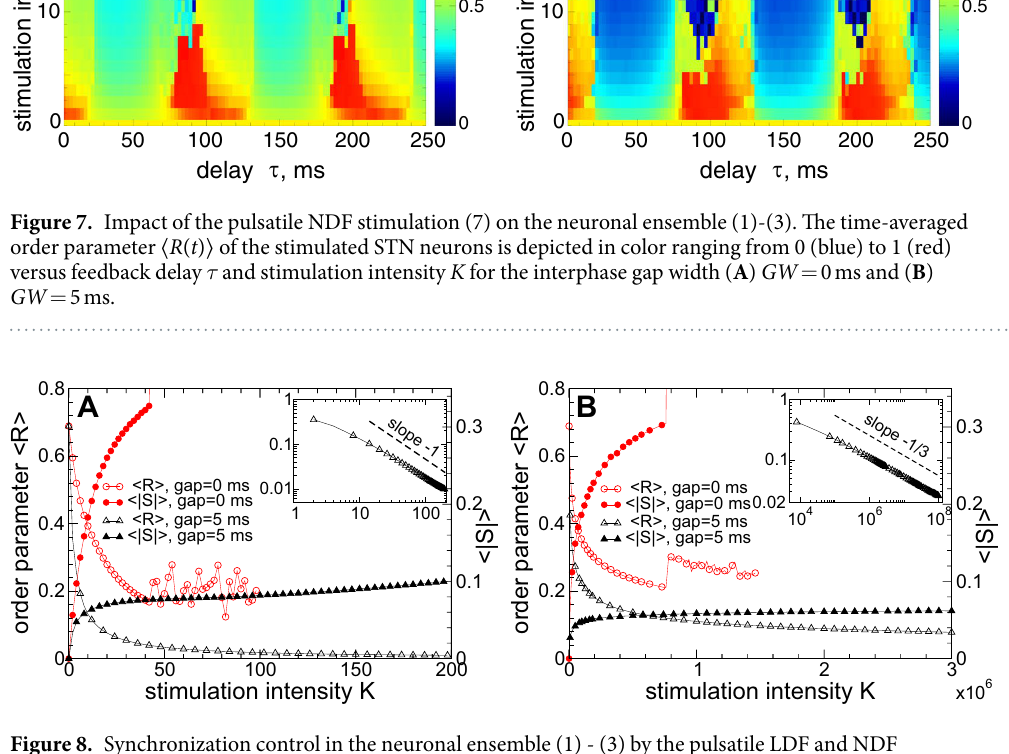
Figure 8. Synchronization control in the neuronal ensemble (1) - (3) by the pulsatile LDF and NDF stimulations for large stimulation intensity. The time-averaged order parameter 〈 R 〉 of the stimulated STN neurons and the time-averaged absolute value 〈 | S | 〉 of the feedback signal S ( t ) are depicted versus K for ( A ) pulsatile LDF stimulation (6) and ( B ) pulsatile NDF stimulation (7) for interphase gap widths GW = 0 ms and 5 ms as indicated in the legends. The scaling for 〈 | S | 〉 is given on the right vertical axes. In the inserts, 〈 R 〉 is plotted in the log-log scale for GW = 5 ms, where the dashed lines have the slopes ( A ) − 1 and ( B ) − 1/3 and are given for comparison. Parameter of the stimulation delay ( A ) τ = 70 ms and ( B ) τ = 150